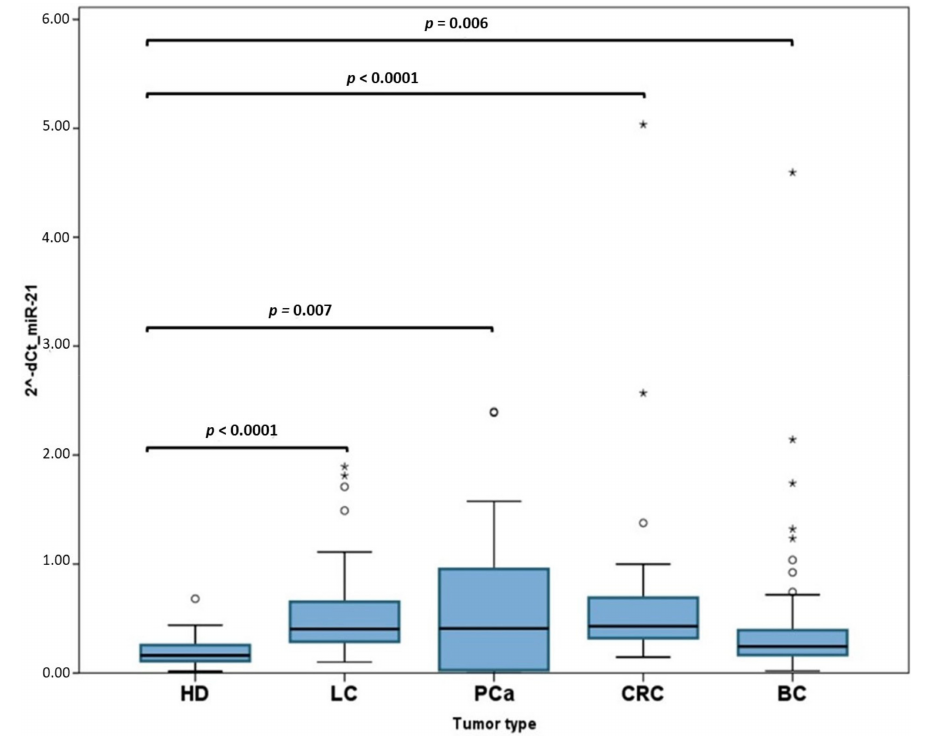
Figure 2. Levels of miR-21 expression in di ff erent tumor groups: All cancer groups show a significantly higher expression of miR-21 compared with healthy donors (HDs). It should be noted that prostate cancer (PCa) cases report the highest dispersion for miR-21